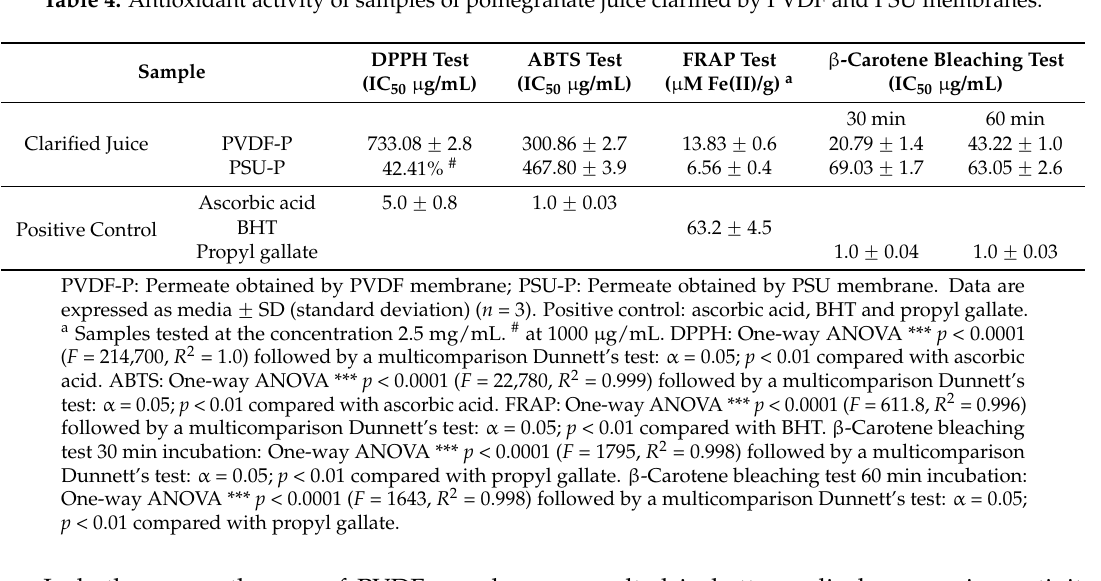
Table 4. Antioxidant activity of samples of pomegranate juice clarified by PVDF and PSU